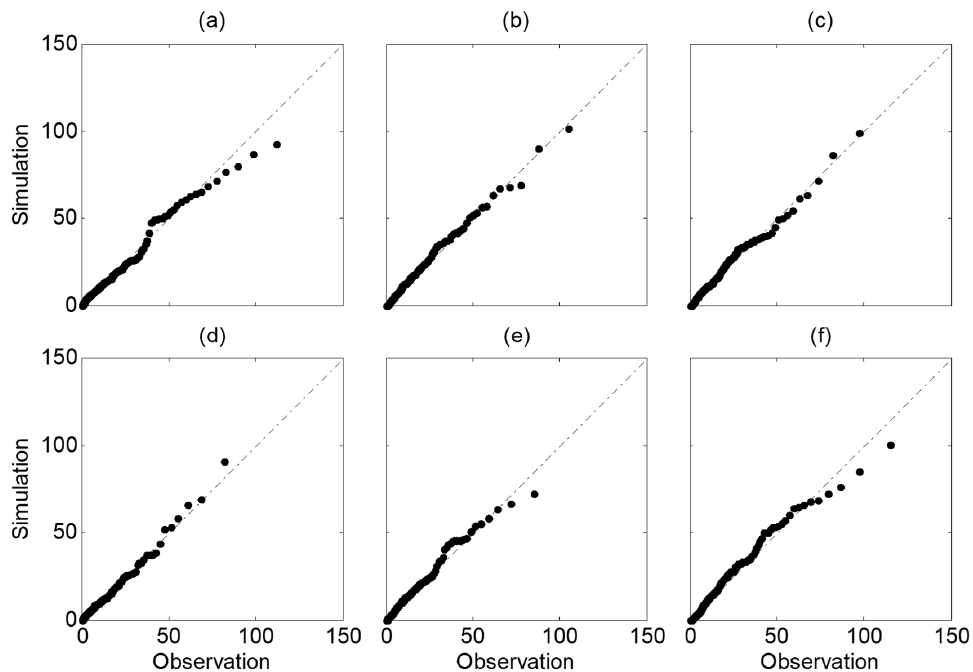
Figure 12. Q-Q plots of summer precipitation (mm day − 1 ) downscaling results (with stations in Beijing, Tianjin, Shijiazhuang, Hohhot, Taiyuan, and Jinan as examples; the horizontal axis is the precipitation observation and the vertical axis is the precipitation downscaling result). ( a ) Beijing, ( b ) Tianjin, ( c ) Shijiazhuang, ( d ) Hohhot, ( e ) Taiyuan, and ( f ) Jinan.